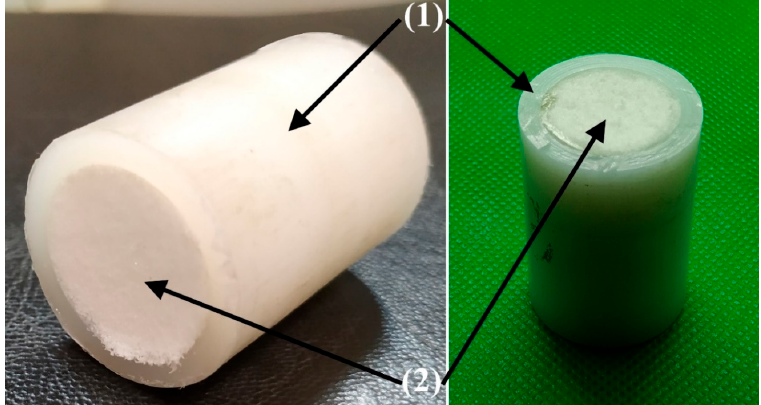
Figure 8. Multi-UHMWPE forms composite of bulk ( 1 ) and porous ( 2 ) UHMWPE.